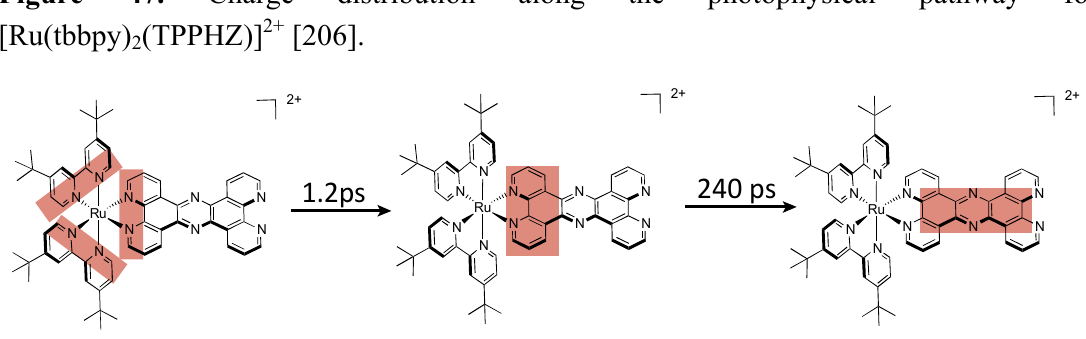
47. Charge distribution along the photophysical pathway for [Ru(tbbpy) (TPPHZ)] 2+ [206]. 2